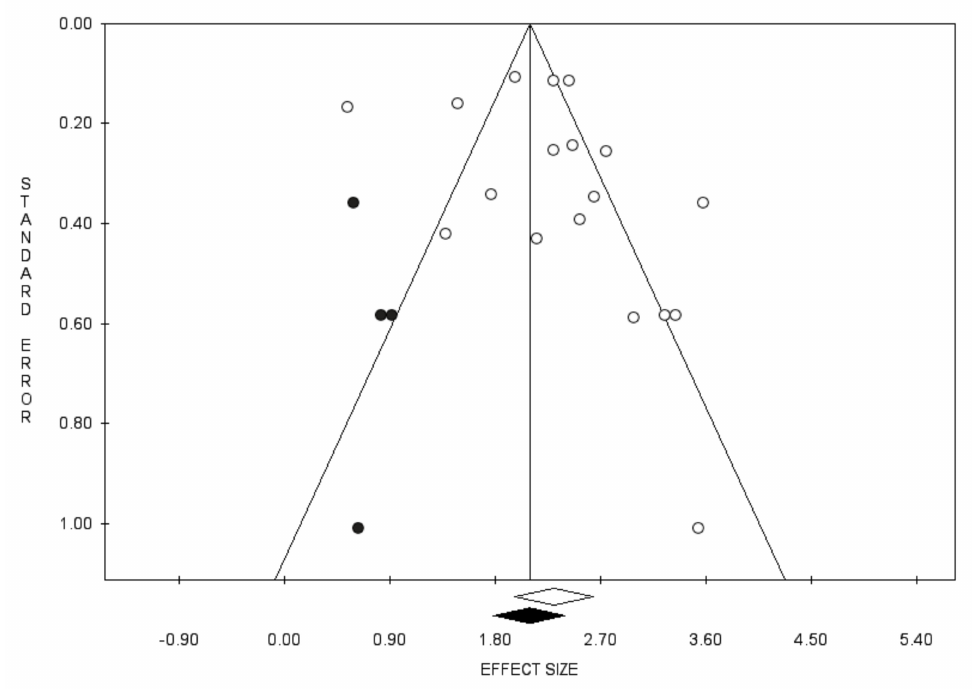
Figure 7. Funnel plot for the prevalence of anamnestic response following challenge dose.